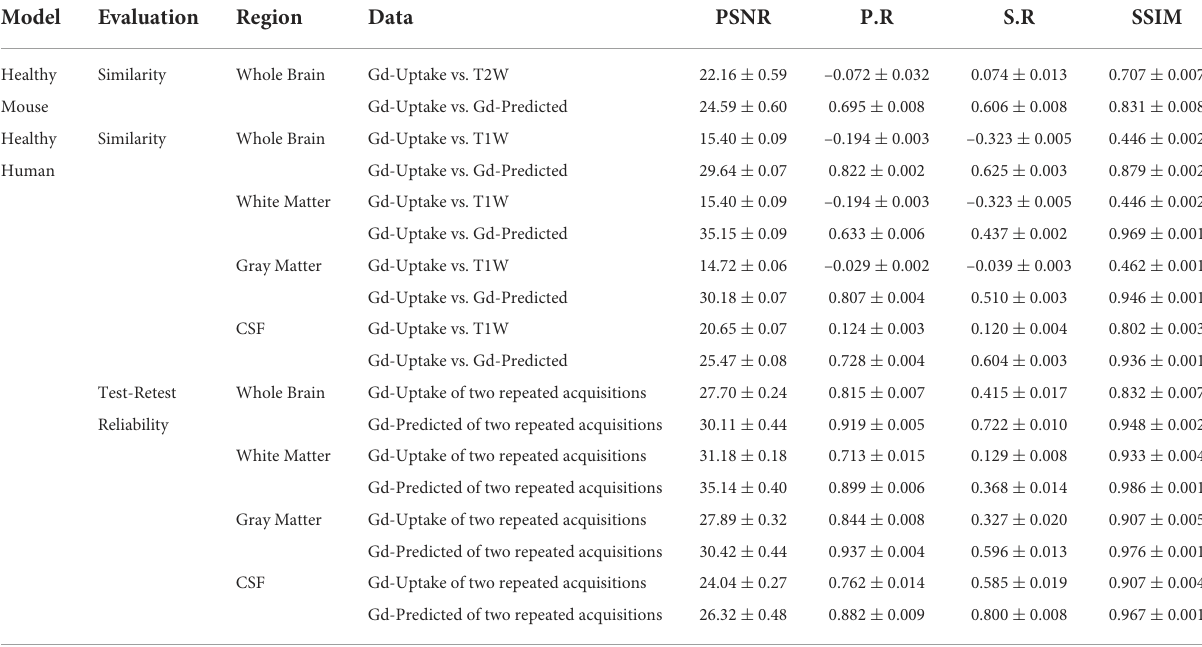
TABLE 1 Quantitative evaluations of DeepContrast